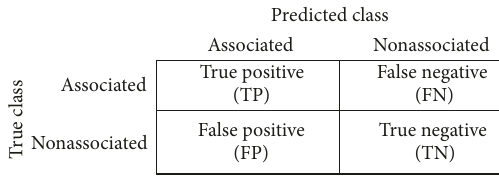
Figure 1: Precision recall explanation